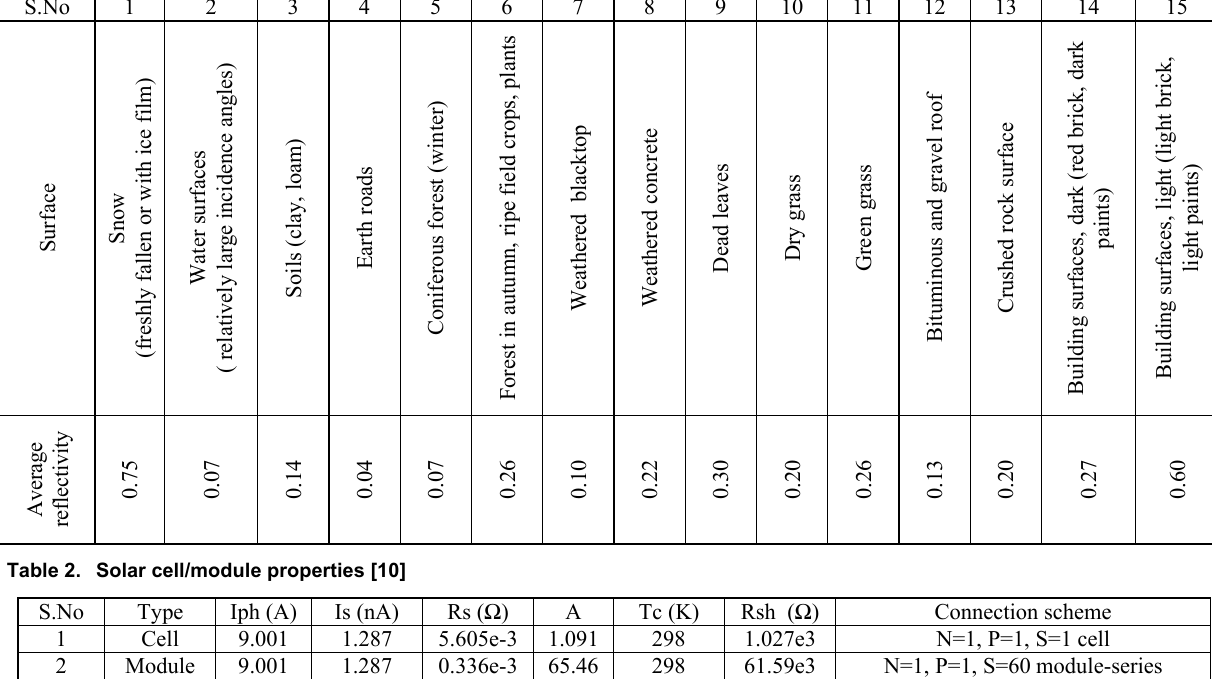
Table 2. Solar cell/module properties [10] S.No